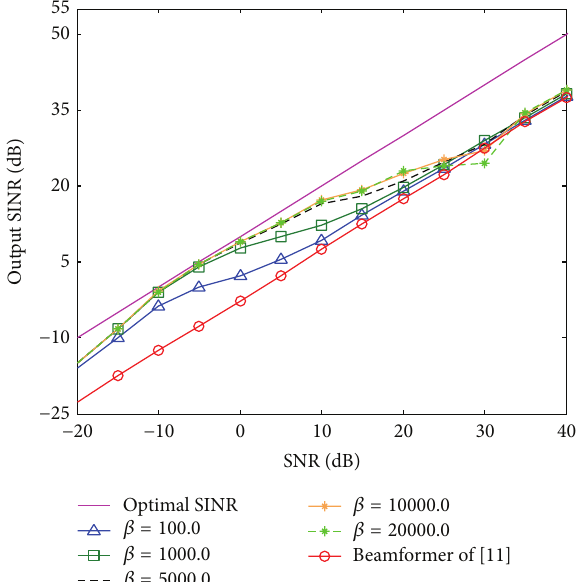
Figure 17: Output SINR versus the input SNR with different 𝛽 (INR = 30 dB).